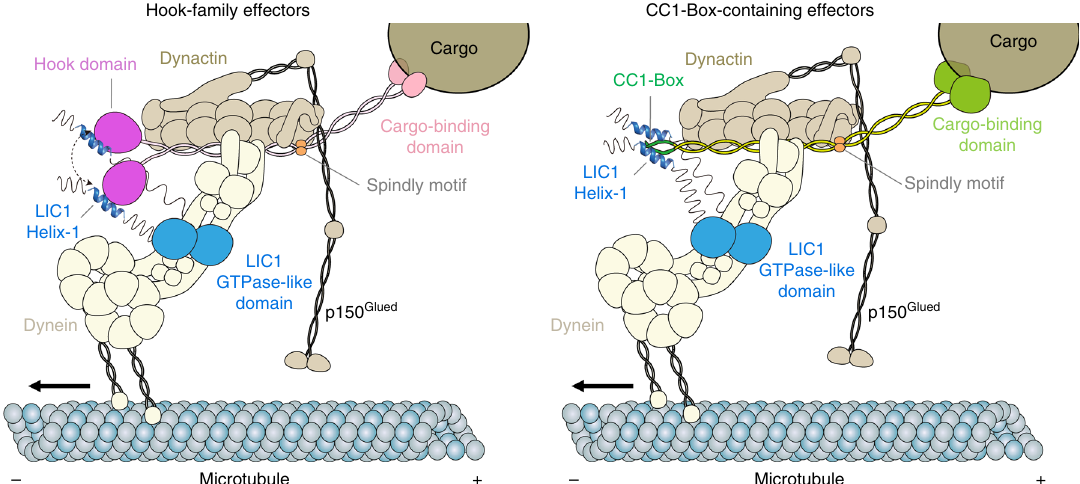
Fig. 6 Model for cargo transport by dynein – dynactin-effector complexes. Dynein is a 1.4 MDa homodimeric complex of two heavy chains, which each binds smaller subunits, including the intermediate chain, light intermediate chain, and three light chains. Dynactin is a ~1.0 MDa complex of more than 20 proteins, including an actin fi lament-like core of actin-related protein 1 (Arp1) subunits, capped at both ends by several subunits, and a 'shoulder' domain from which emerges the largest subunit, p150 Glued , which projects ~50 nm and can bind microtubules directly to help initiate a processive run. Although dynein and dynactin bind directly to each other via the dynein intermediate chain and the dynactin p150 Glued subunit 30 – 33 , they form a stable processive complex only in the presence of effector proteins, including Hook1/3 5,8,9 , BICD2 5 – 7 , Spindly 5 , FIP3 5 , and NIN/NINL 10 . These effectors are unrelated to each other in sequence and recruit different cargoes. Here we have demonstrated that independent of these differences, they all appear to interact with the same region of the dynein LIC1 subunit, which we named Helix-1 (or Effector-Binding Helix, EBH). The interaction involves the Hook domain in Hook-family effectors (left) or a coiled-coil segment in CC1-Box-containing effectors, such as BICD and Spindly (right). We have proposed here that the LIC1-effector interaction may help stabilize the 'parallel-heads' conformation thought to be necessary for dynein processivity